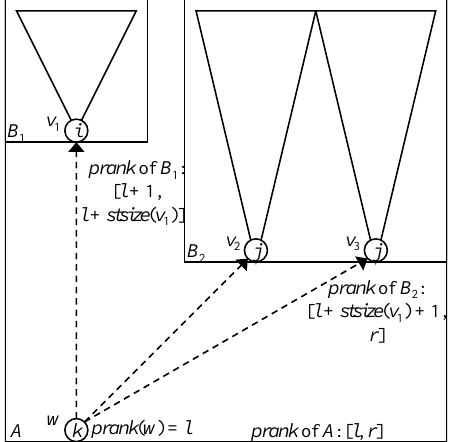
Figure 8. Computing real preorder ranks from the 0-terminal node to real nodes with higher